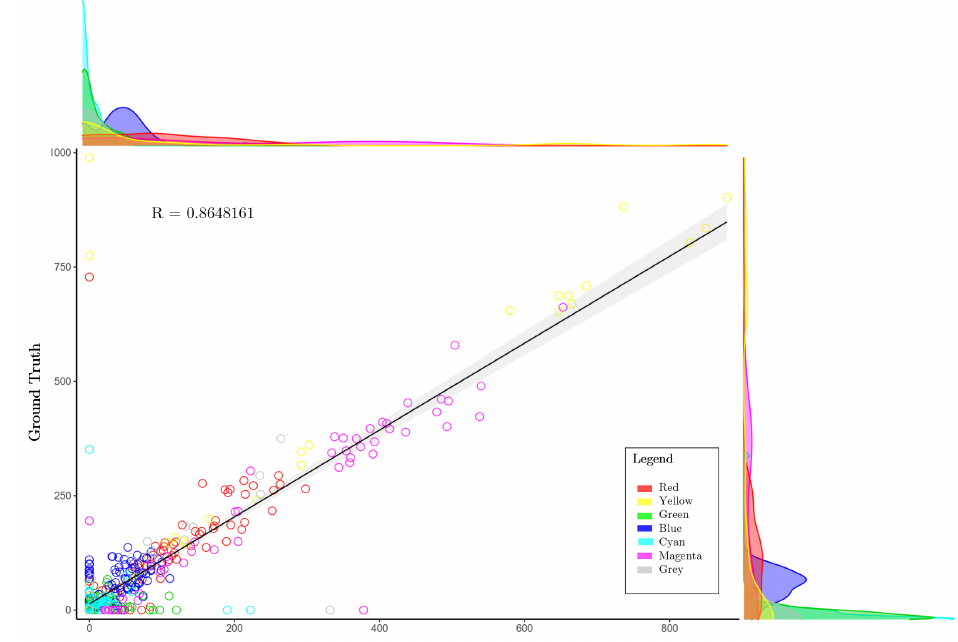
Figure 6. Scatter plot showing the spread of leaf growth, in terms of the relationship between the ground truth ( y axis) and forecast images ( x axis) as biomass increase. Point colors correspond to the 7 individual RGB leaf color classes used in the segmentation masks. Line of best fit (black line) with smoothed conditional means at the 95% confidence interval (gray region) are included, as well as the PCC result (R value).